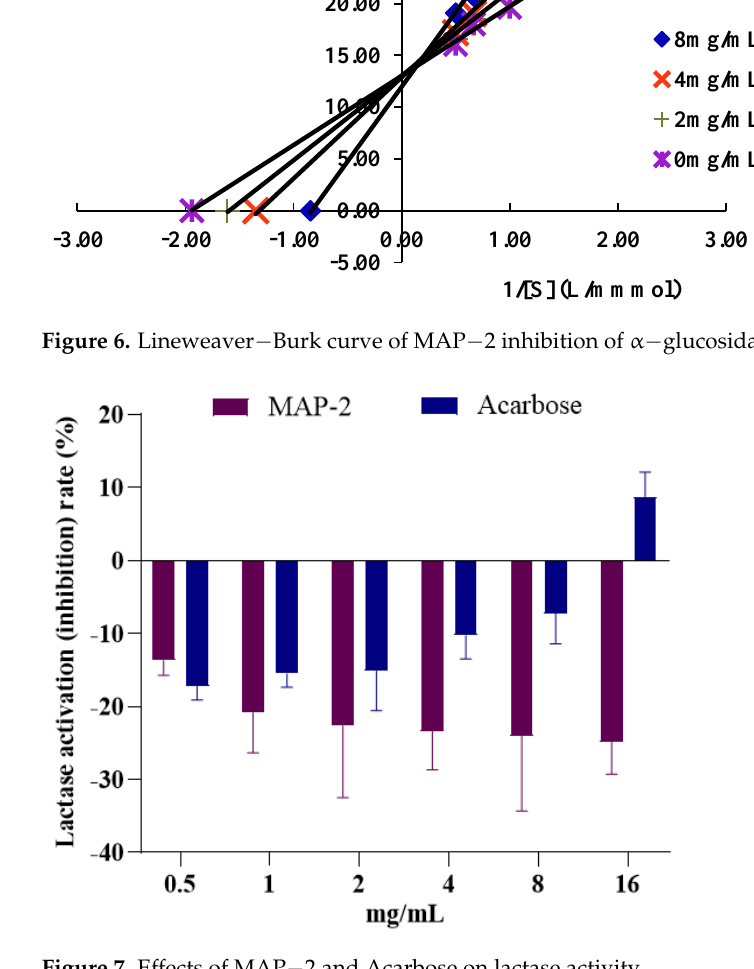
Figure 7. Effects of MAP−2 and Acarbose on lactase activity.